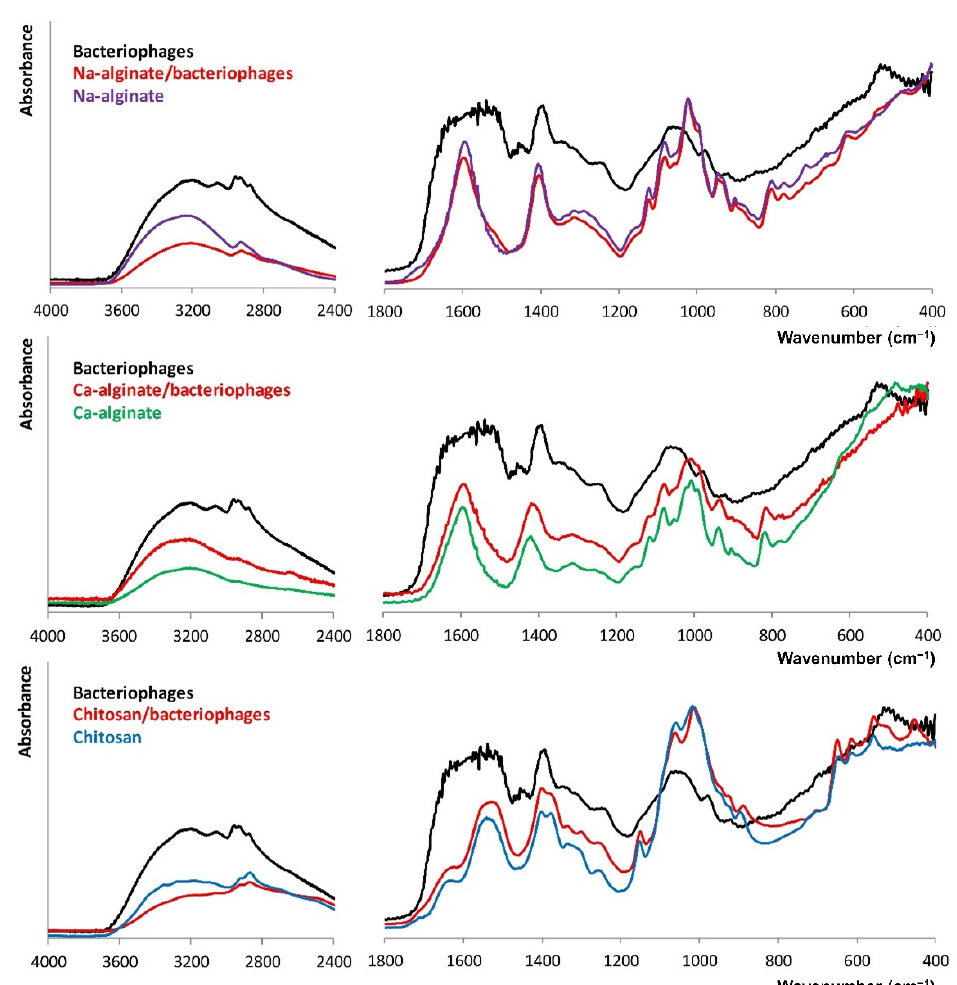
Figure 3. FT-IR spectra of the Pyo bacteriophages containing biopolymer films compared to the FT-IR spectra of the plain biopolymer films and dried bacteriophage suspensions.